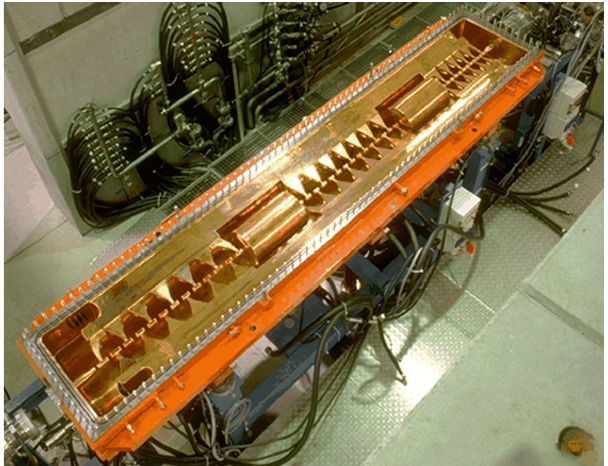
FIG. 1. View on the 108 MHz, 9.4 MV GSI-HLI cavity after taking away the upper half shell. The IH-type drift tube structure shows three KONUS sections with two internal quadrupole triplet lenses. The water cooling distribution needed for 50% duty factor operation is visible in the